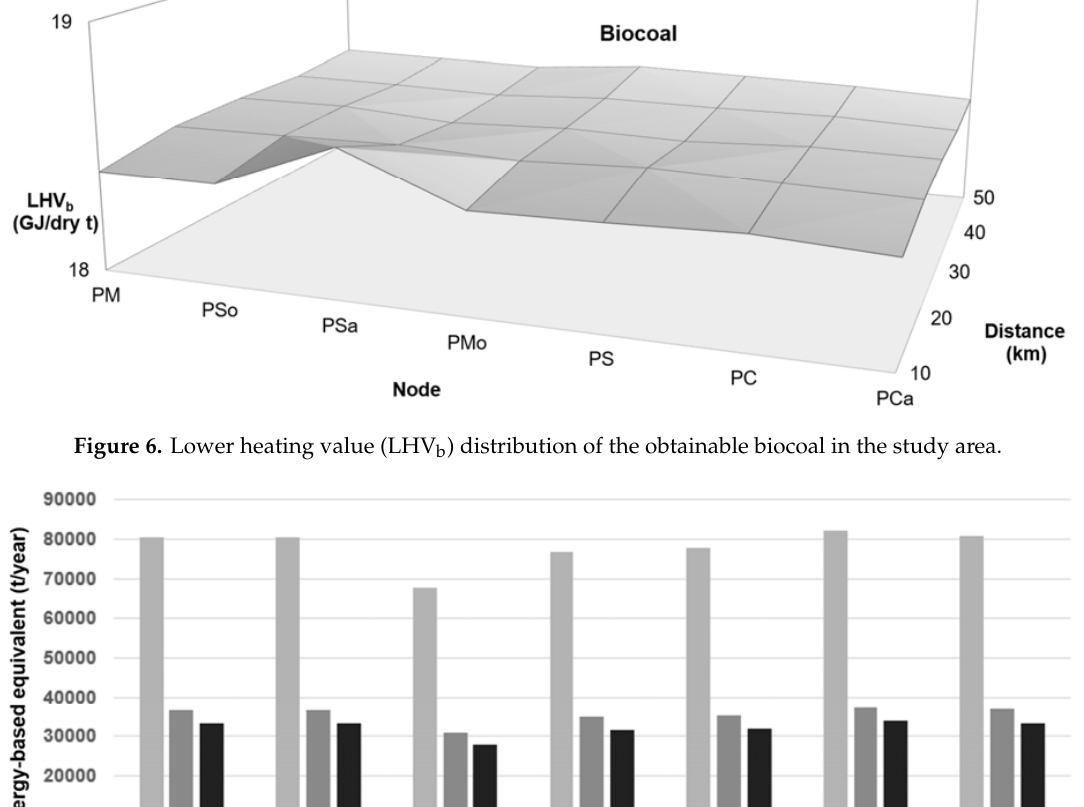
Figure 5. Mass and energy per candidate node in the study area: ( a ) biocoal (m b ), ( b ) bioenergy (E b ). Furthermore, the LHV distribution of the biocoal obtained from the raw material collected in the study area has been evaluated per candidate node (Figure 6).